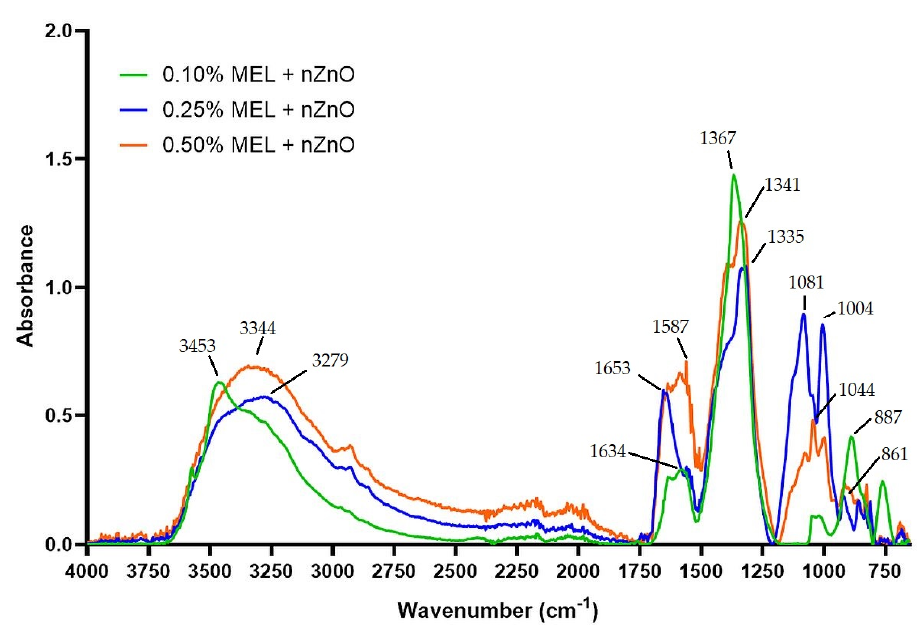
Figure 3. FTIR spectra of obtained zinc oxide nanoparticles samples.